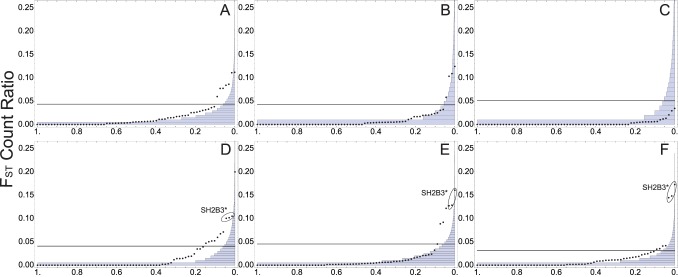
Genome-wide high-FST ratio decay and non-HLA risk loci values.In each plot, the histogram represents the genome-wide distribution (11,000 samples) of the fraction of SNPs in each locus with FST higher than the 99% genome-wide upper boundary (black line) this distribution is plotted against the high- FST ratio for each CD risk locus bin in this analysis ordered from smallest to largest. Dots above the line represent loci with significantly elevated high- FST ratios (P<0.05). Raw data for CD regions is found in Table S1. a. within Africa, b. within East Asia, c. within Europe, d. between Europe/East Asia, e. between Africa/East Asia, f. between Africa/Europe.